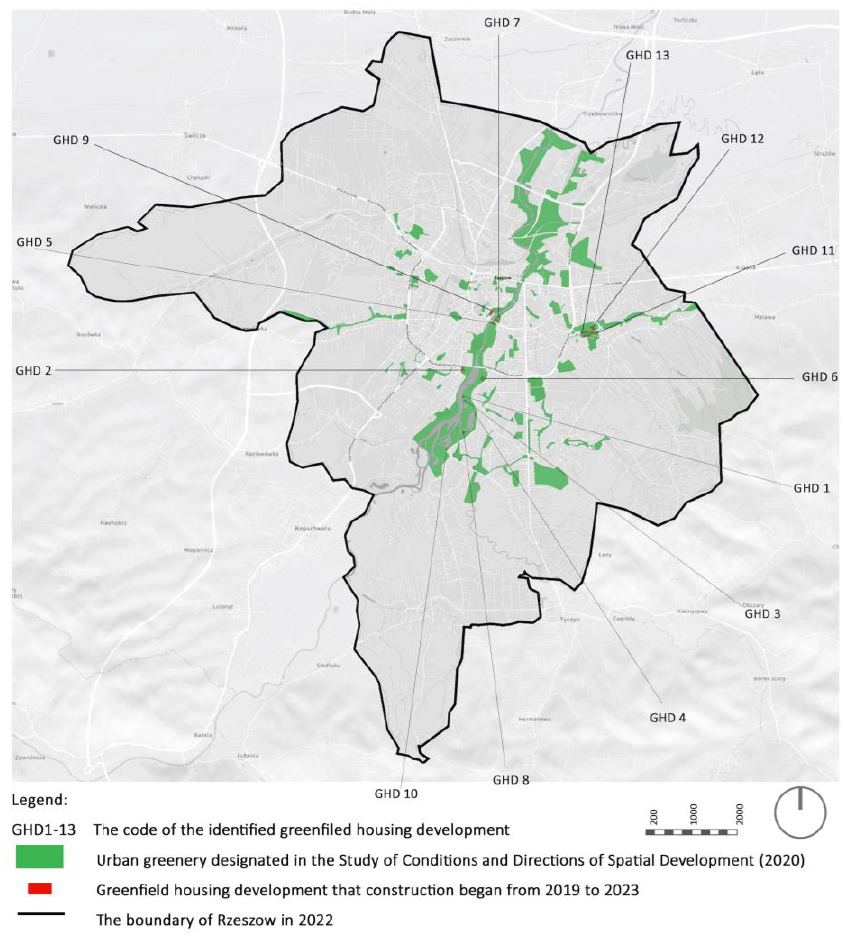
Figure 1. Map of Rzeszow: the distribution of UGI and the location of GHD that construction began from 2019 to 2023.